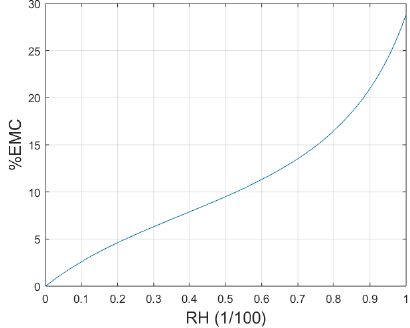
Figure 2. %EMC variation with the RH (at 27 °C).